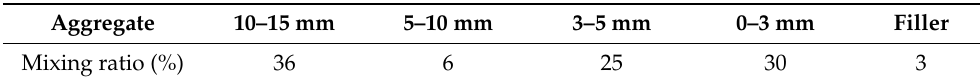
Figure 2. Composite aggregate gradation of asphalt mixture. Table 6. Mixing ratio of aggregates.